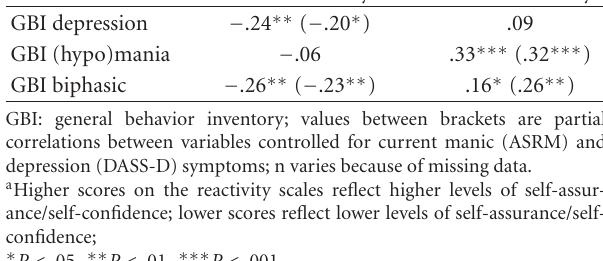
Table 1: Correlations and partial correlations (current manic and depression symptoms partialled) between depression ( n = 151), (hypo)mania ( n = 151), and biphasic ( n = 156) GBI-scores and failure and success reactivity.